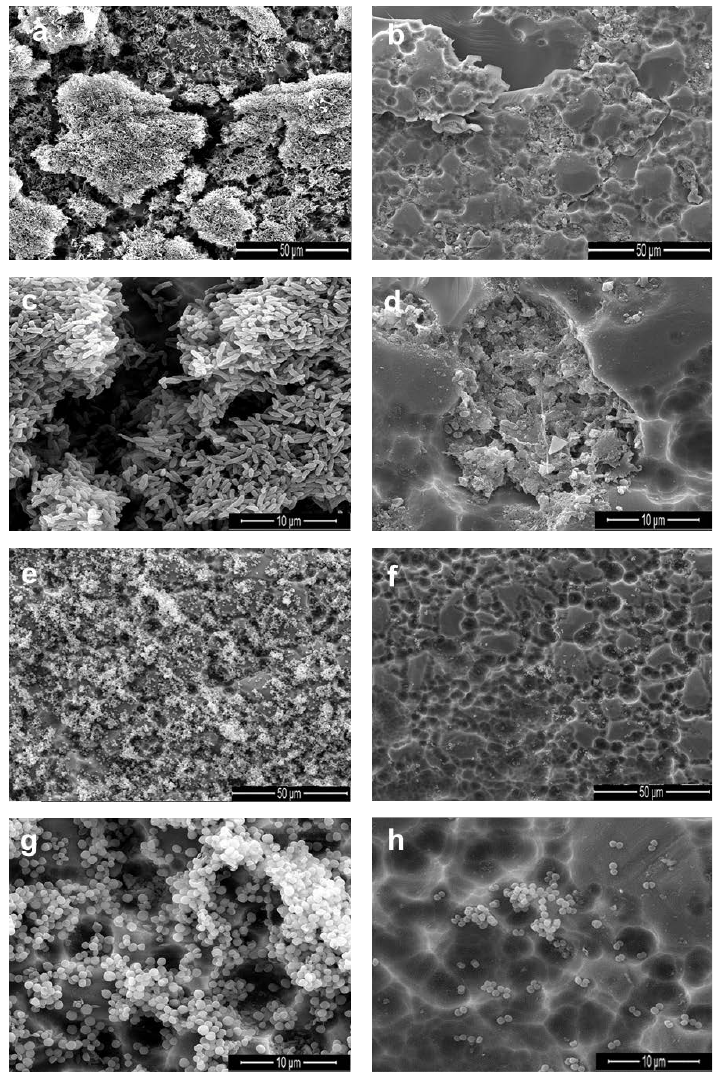
Figure 5. SEM images of biofilm formation in E. coli O157:H7 ( a , c ) and S. epidermidis ( e , g ). Biofilm disruption on E. coli O157:H7 ( b , d ) and S. epidermidis ( f , h ) after EO treatment. SEM images were recorded at 2000× and 8000× magnification.